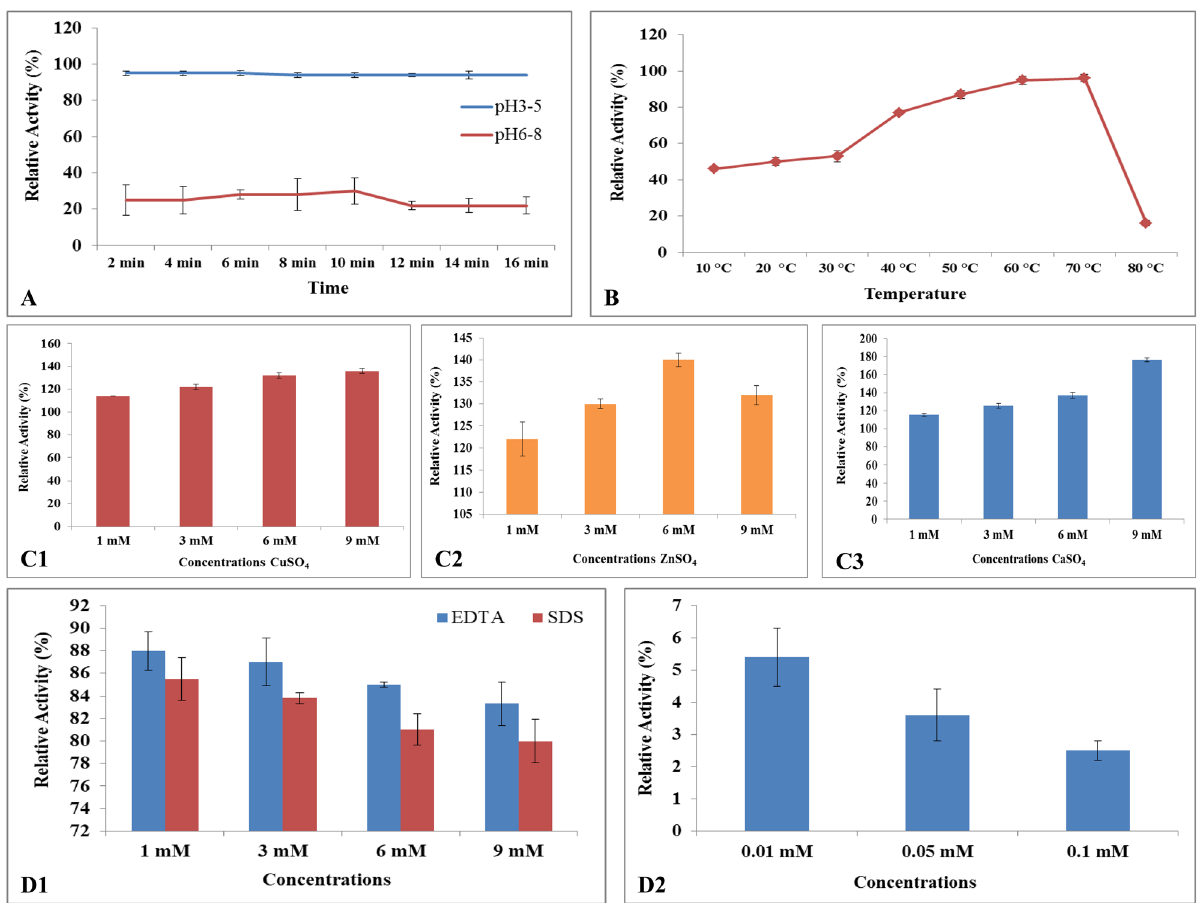
Figure 4. Characterization of purified Glacc110 extracted from G. leucocontextum. ( A ) Effects of pH ranges on purified Glacc. ( B ) Effects of T on purified Glacc110. ( C ) Effects of metallic ions on purified Glacc. ( C1 ) Effects of CuSO 4 (1, 3, 6, 9 mM) on purified Glacc110. ( C2 ) Effects of ZnSO 4 (1, 3, 6, 9 mM) on purified Glacc110. ( C3 ) Effects of